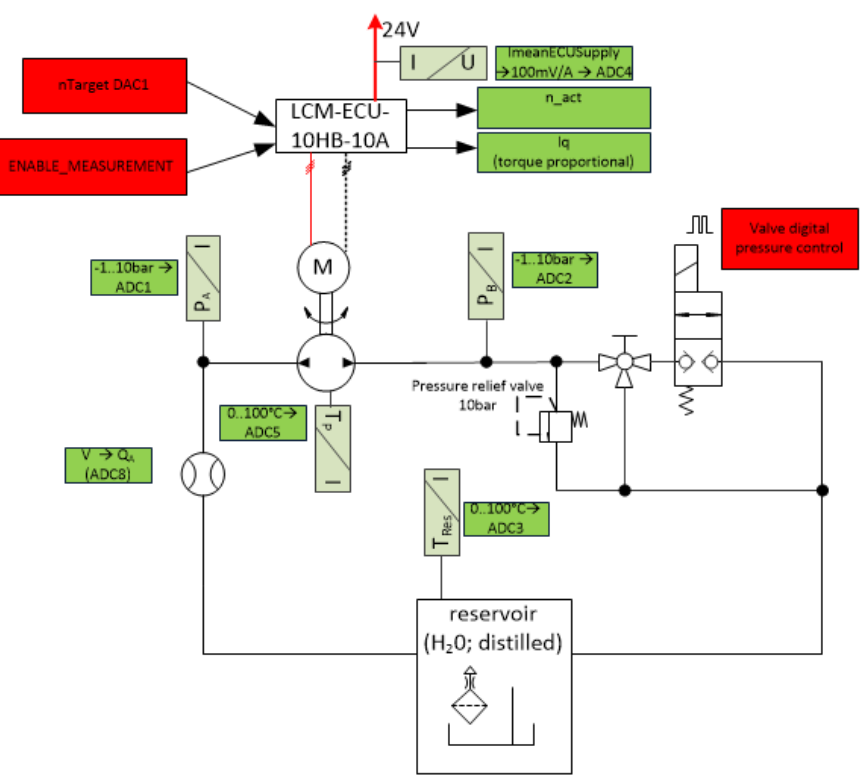
Figure 21. Scheme of the test rig (hydraulic and electrical circuit).